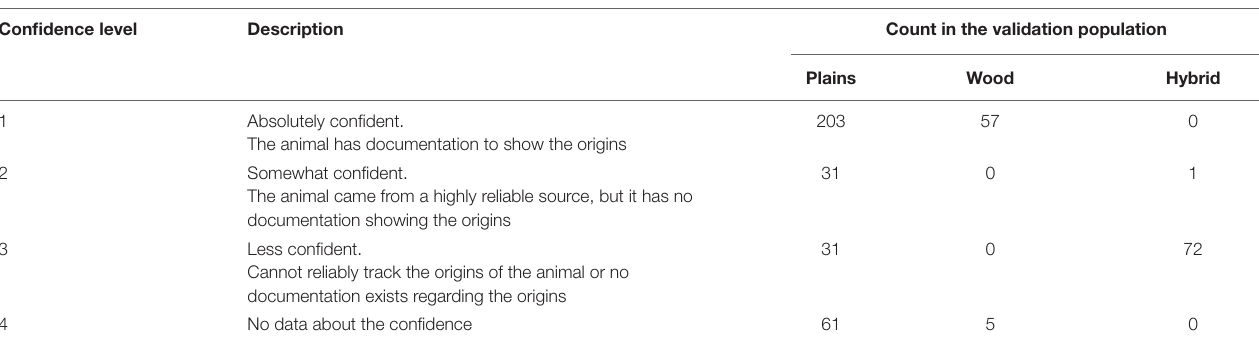
FIGURE 2 | SNP selection procedure for the custom panel for parentage and subspecies composition analysis. TABLE 2 | Confidence level of the subspecies label in the validation